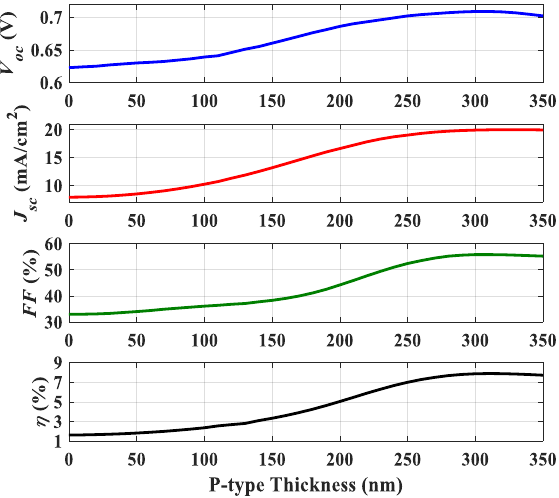
Figure 4. Impact of p-layer thickness on the photovoltaic parameters.